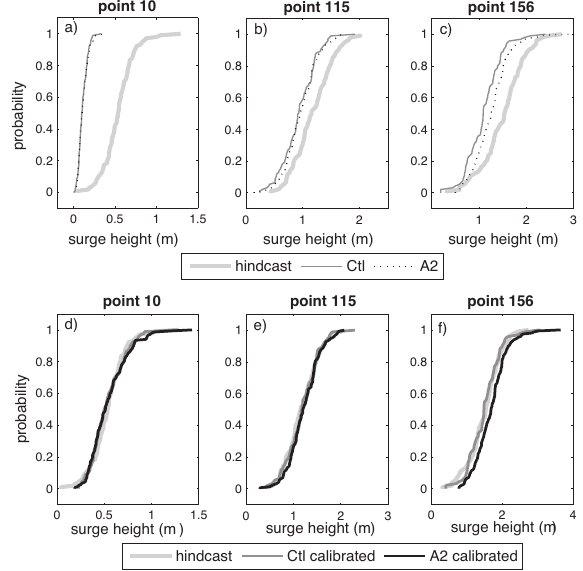
Fig. 6. Examples of three points 10, 115, 156 (location see Fig. 1) for the cumulative distributions of hindcast and scenario storm surge event sets: uncalibrated ( a , b and c ) and calibrated ( d , e and f ).